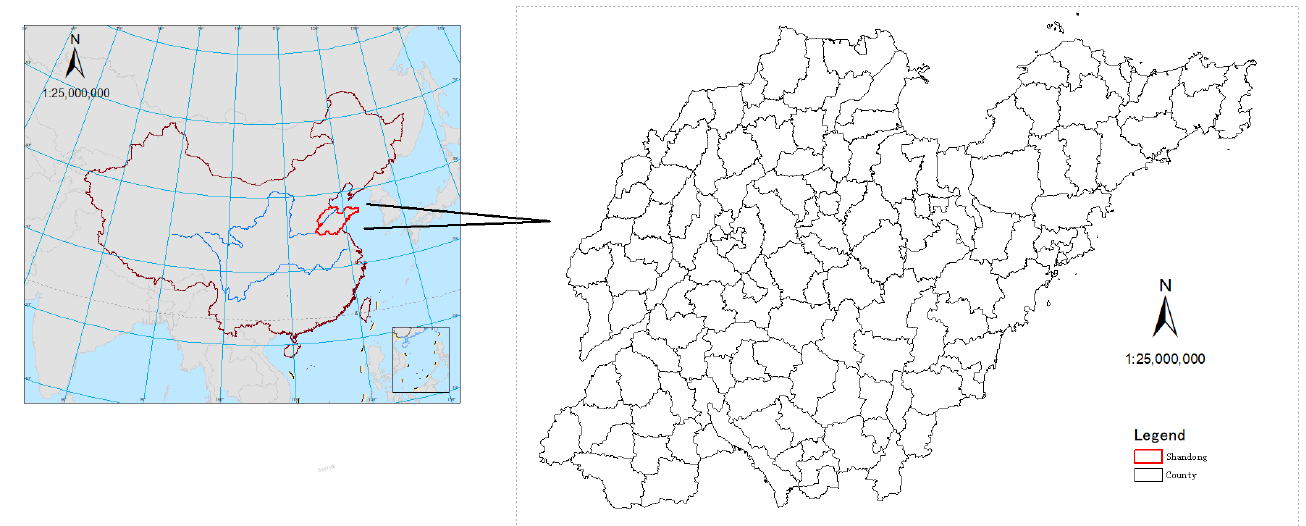
Figure 3. Location of the study area.